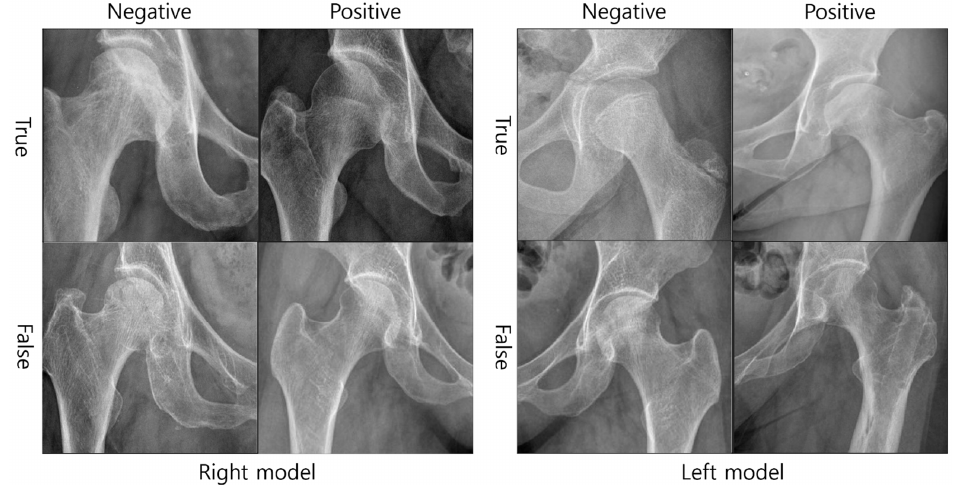
Figure 4. Examples of classification of diagnostic results by the developed model.